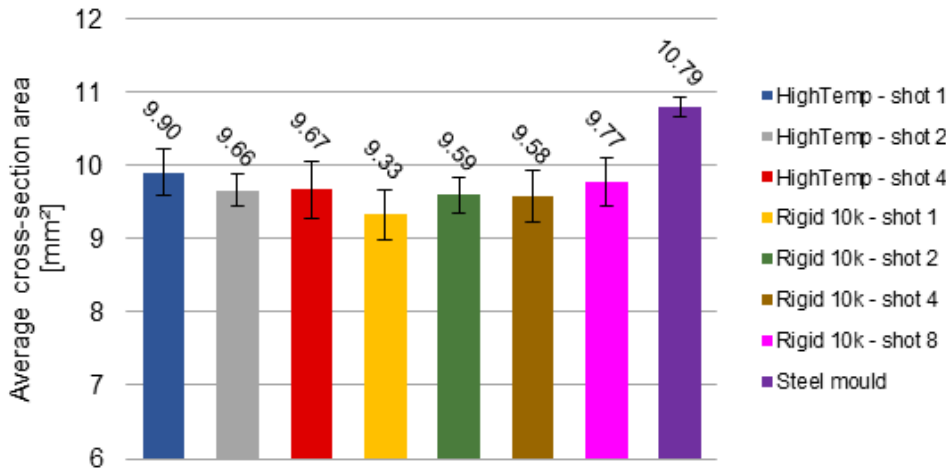
Figure 11. Cross-section area measures of PP sample groups moulded using different tool inserts. ASTM D638 type V tensile specimens have a nominal narrow-section cross-section area of 10.11 mm 2 ( l = 3.18 mm). According to Martinho et al. (2009), the expected linear